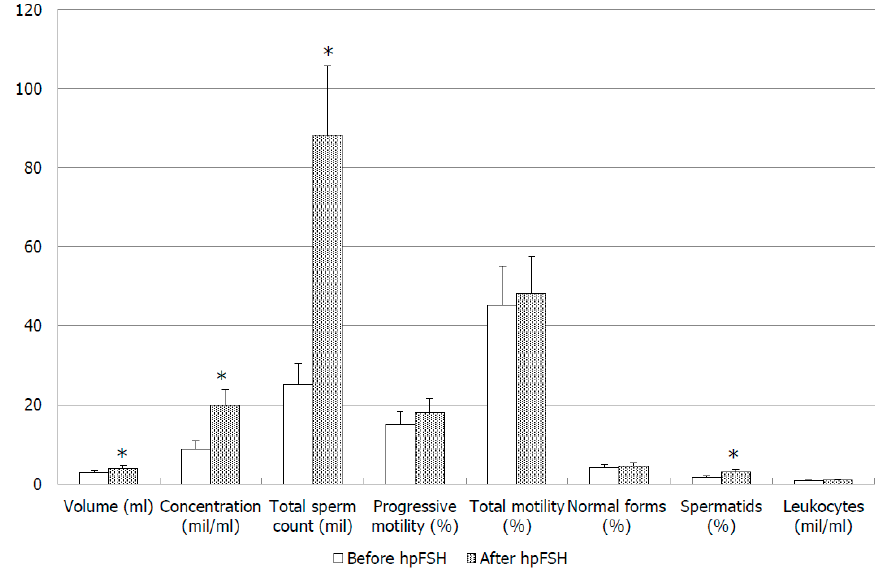
Figure 1. Conventional sperm parameters before and after treatment with high purified follicle ‐ stimulating hormone (hpFSH) in infertile responder patients, * p <